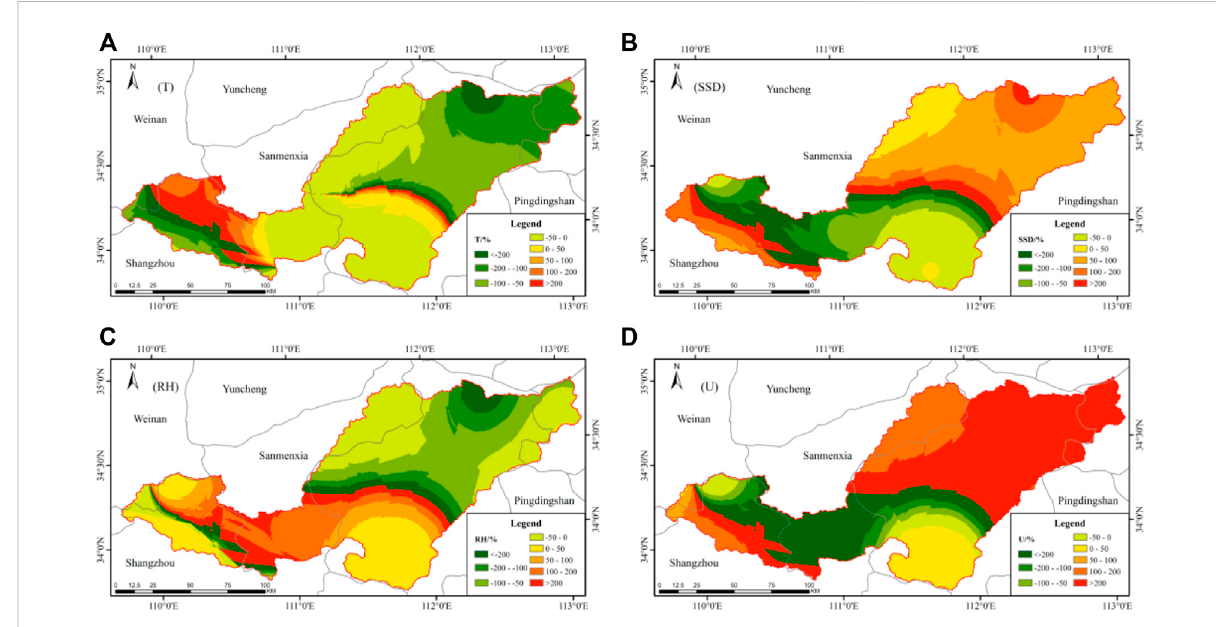
The proportional contributions of the meteorological factors on the spatial scale: (A) The proportional contributions of T; (B) The proportional contributions of SSD; (C) The proportional contributions of RH; (D) The proportional contributions of U.